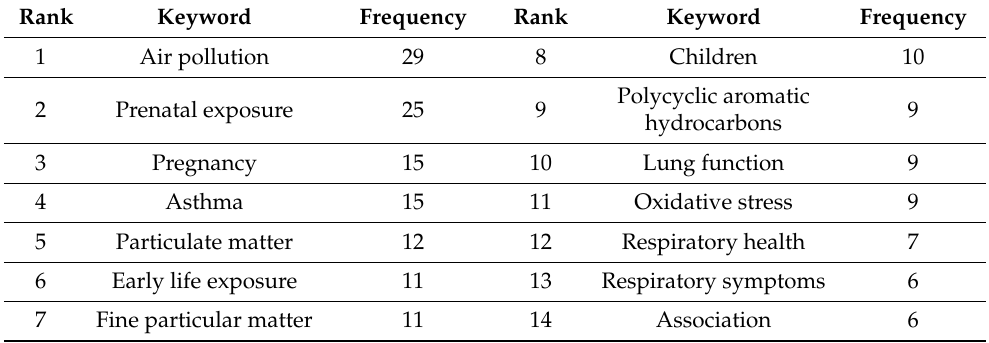
Figure 9. Expanded country/region collaboration map. The Table 2 below indicates the top 14 keywords with the highest occurrence in the literature of prenatal exposure to air pollution. Table 2. Top 14 keywords with the highest frequency in prenatal exposure to air pollution